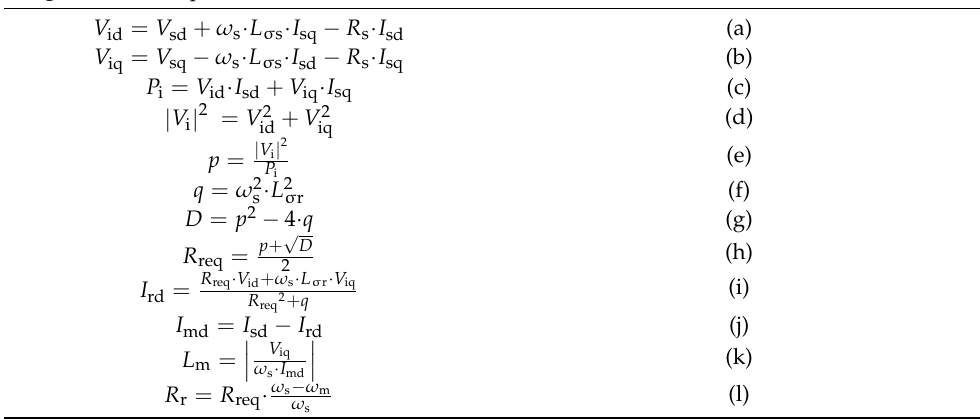
Algorithm 1. Proposed method for simultaneous estimation of R r and L m .